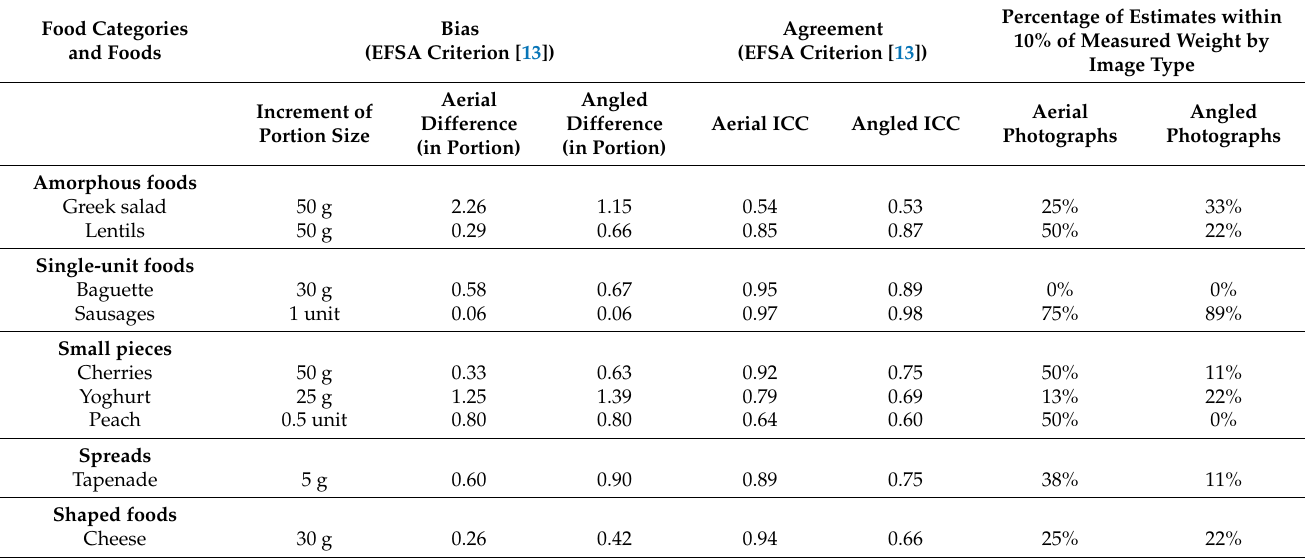
Table 4. Results of photograph evaluation: comparison of image type with respect to bias, agreement, and estimation within 10% of measured